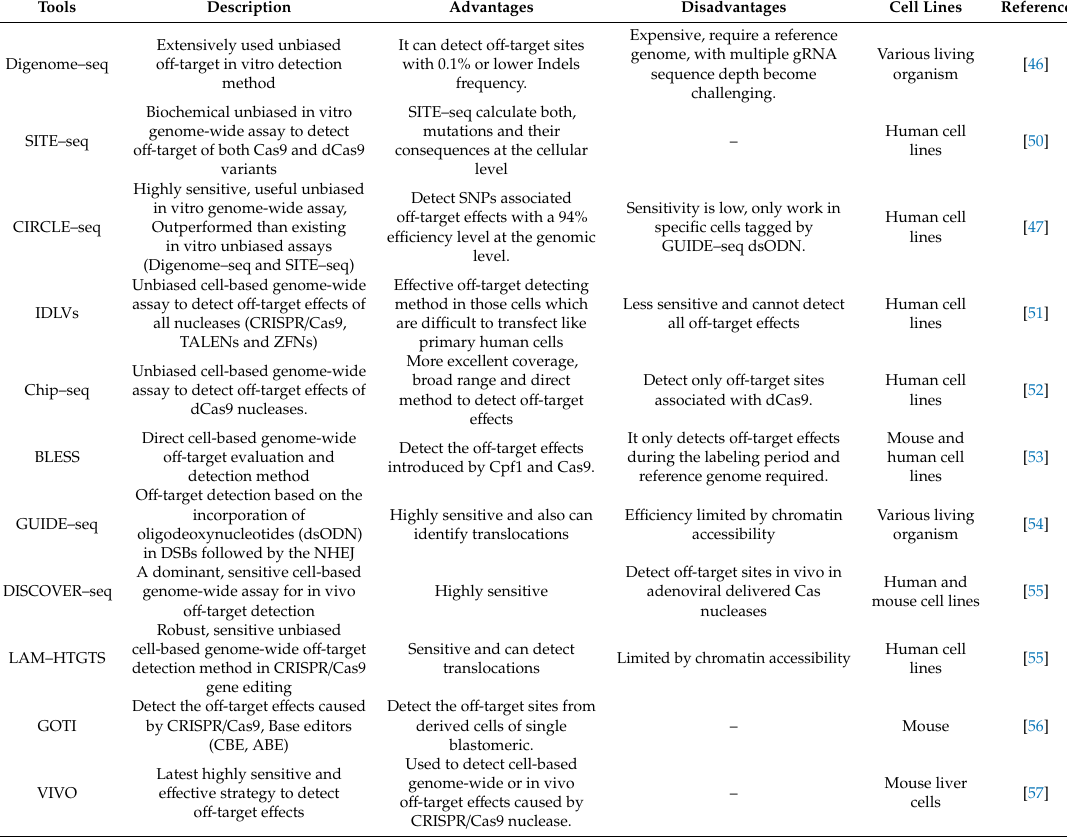
Table 3. Unbiased methods to detect and evaluate o ff -target sites in living